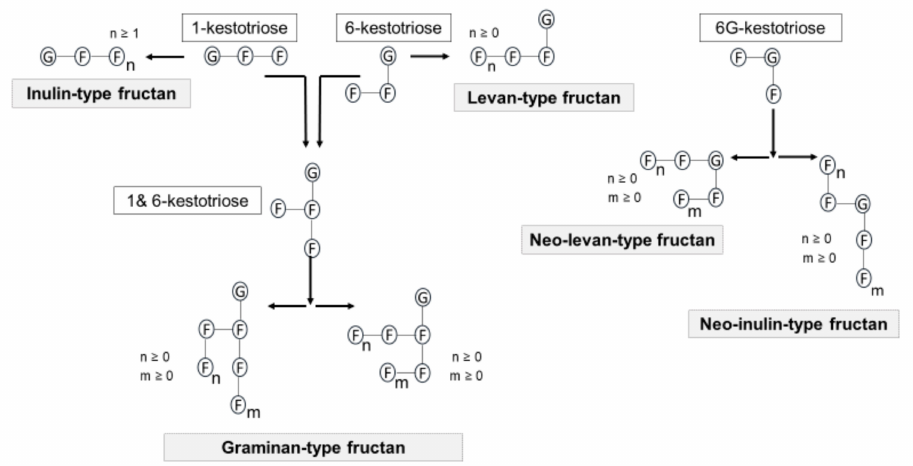
Figure 5. Three core trisaccharides are the main building blocks for different types of fructans. G and F represent glucose and fructose residues, respectively. Based on Verspreet et al.